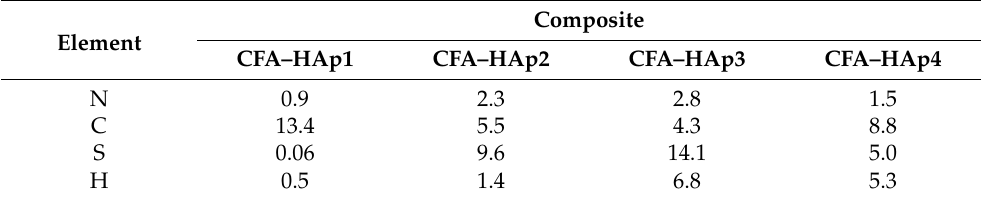
Table 3. Elemental analysis of the CFA–HAp composites (% w / w